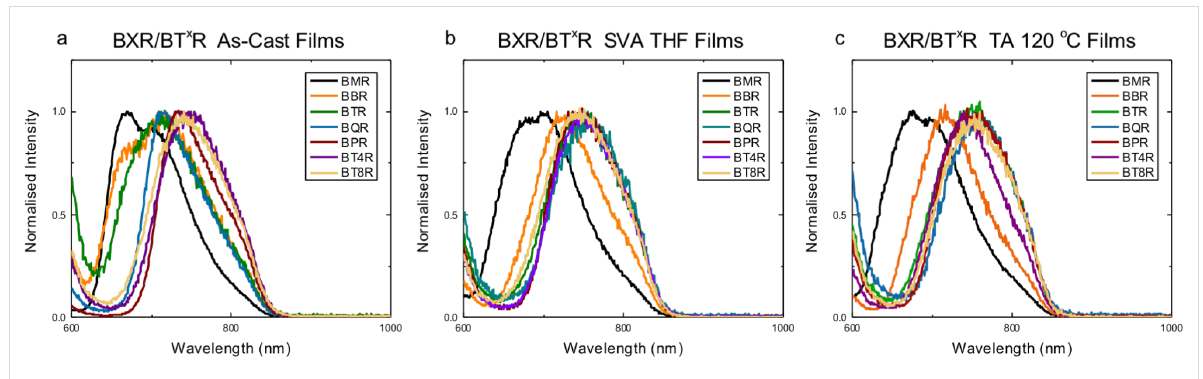
Figure 7: Normalised thin film fluorescence emission profiles for BX x R series after excitation at 580 nm, a) as-cast films (from CDCl 3 ), b) after sol- vent vapor annealing (SVA with THF for 10 seconds), and c) thermally annealed (TA) at 120 °C for 10 minutes.